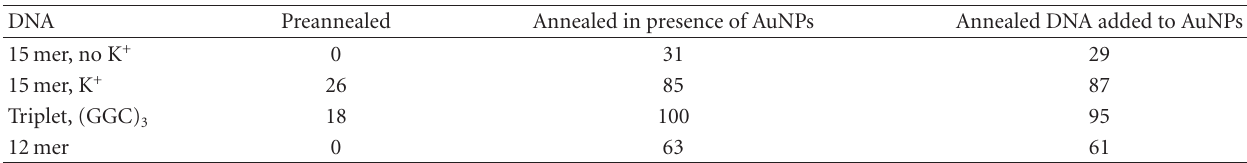
Table 1: Percent change ( ± 4%) in gold nanoparticle PRLS signal, in presence of preannealed and annealed DNA, and when samples were annealed in the presence of nanoparticles. DNA concentration is 2.1nM in each